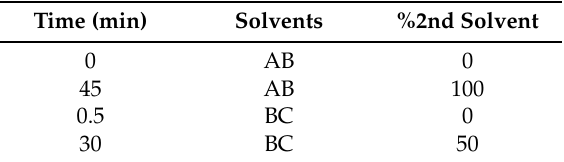
Table 1. Flash chromatography gradient system used.